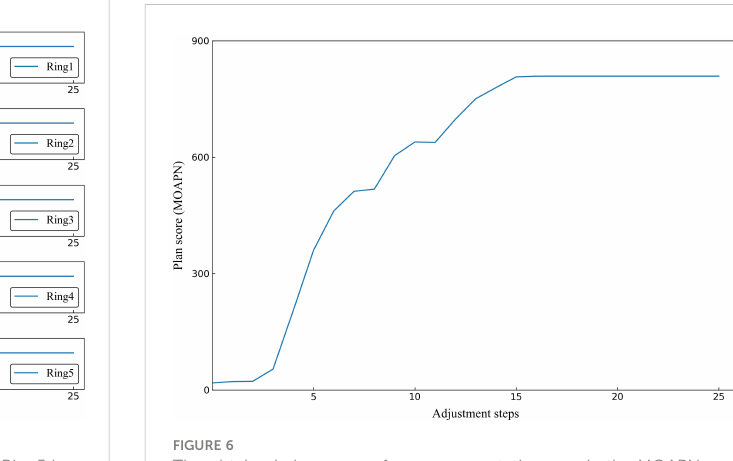
FIGURE 5 The selected action values of Ring1, Ring2, Ring3, Ring4 and Ring5 in the adjustment steps for one representative case.